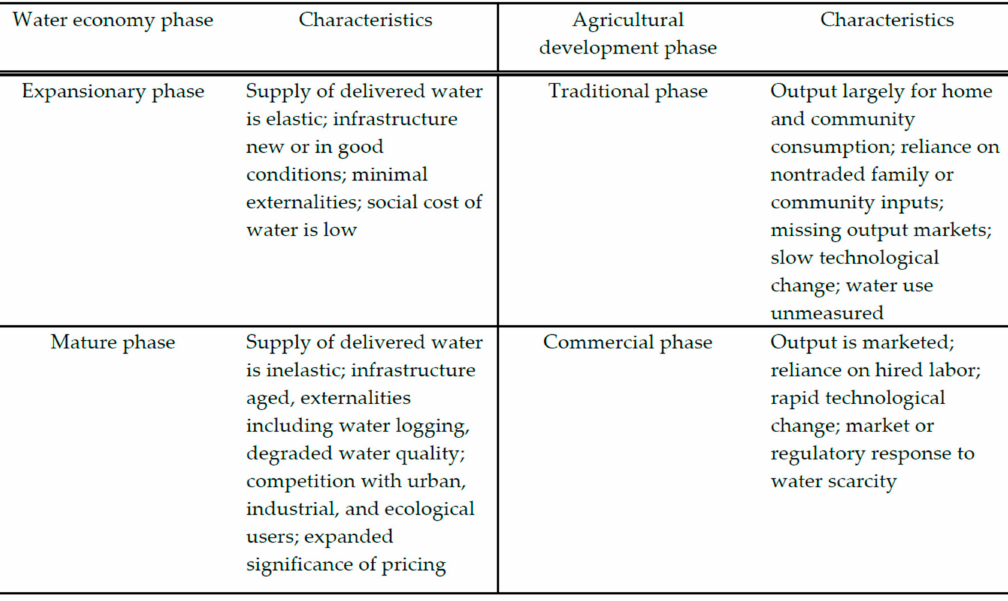
Figure 3. Summary of the distinction between expansionary and mature water economies [15] and a simple dichotomy between traditional and commercial